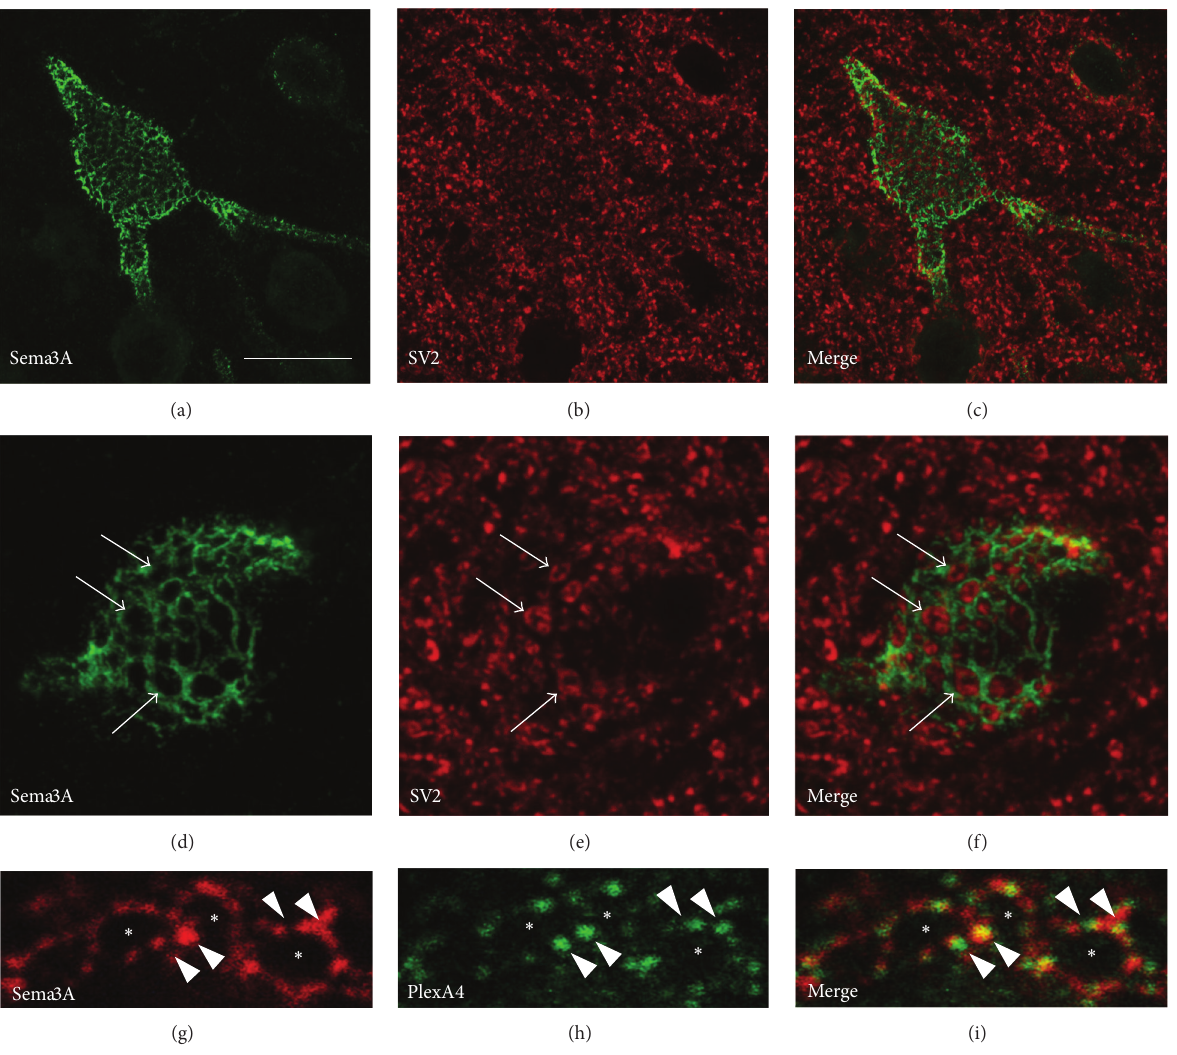
Figure 3: Sema3A expression in PNN. Confocal microscopy shows Sema3A immunoreactivity (green) which surrounds the somatodendritic compartment of an interneuron in the rat neocortex. Sema3A staining displays a honeycomb-like pattern which is typical for the structure of PNNs (a)–(c). Colabeling with the presynaptic marker SV2 (red) reveals that synaptic boutons on the neuron surface fill the holes in the Sema3A-positive honeycomb-like structure of the PNN ((d)–(f), arrows). The Sema3A receptor component PlexinA4 (green) is closely associated with the Sema3A (red) positive net. Like Sema3A, PlexinA4 (arrowheads) is not present in the holes (asterisks) of the honeycomb- like structure of the PNN (g)–(i). Scale bar for (a)–(c) is 20 𝜇 m; for (d)–(f) is 8 𝜇 m; for (g)–(i) is 3.5 𝜇